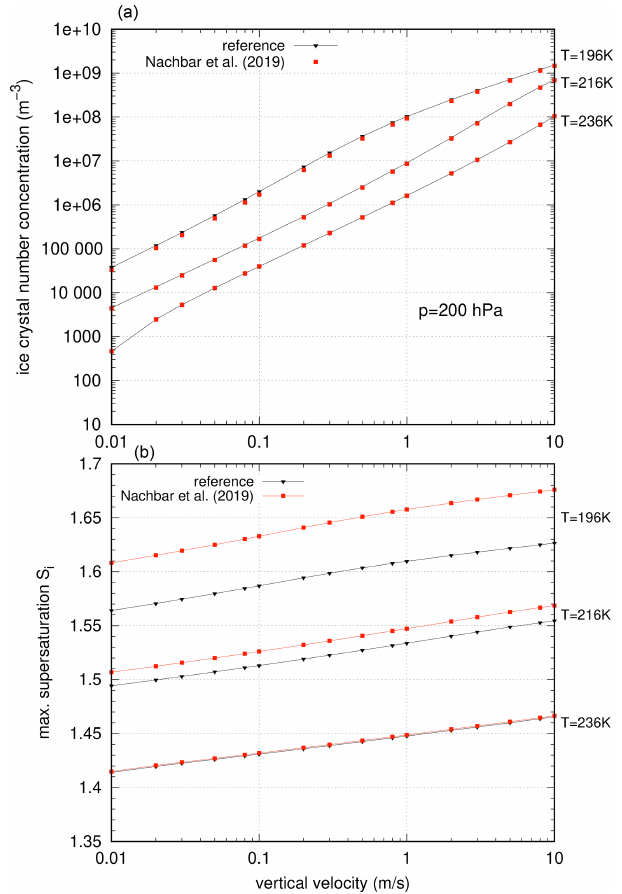
Figure 10. Impact of the formulation of the saturation vapour pres- sure by Nachbar et al. (2019) on the idealized nucleation events. (a) Ice crystal number concentrations and (b) maximum supersatu- ration values. The relative differences in number concentrations are always smaller than 15%.